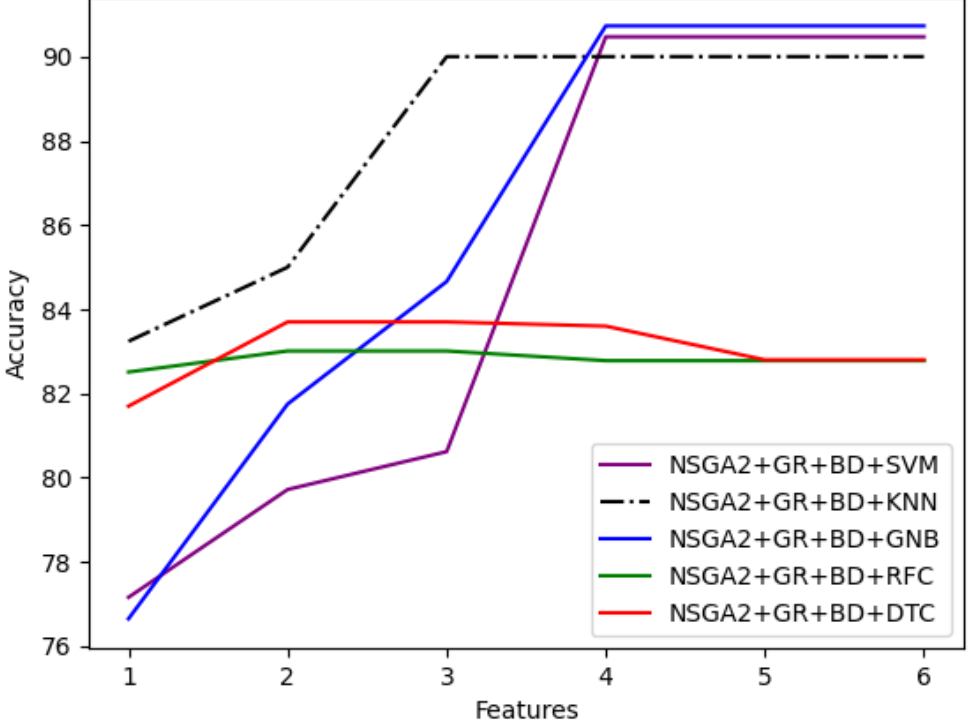
Figure 8. Hybrid NSGA2 + Bi-directional + GR feature selection performance.